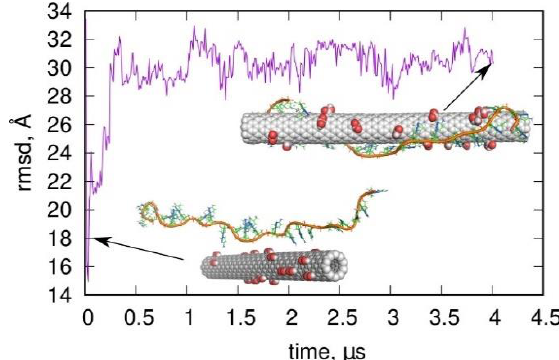
Figure 5. Evolution of cytosine-rich DNA fragment in contact with carboxylated carbon nanotube. The inset on the left shows the initial arrangement of the CNT and DNA, while the inset on the right shows the final state with DNA wrapped around the CNT. The calculations were performed using the bsc1 parametrization for DNA.